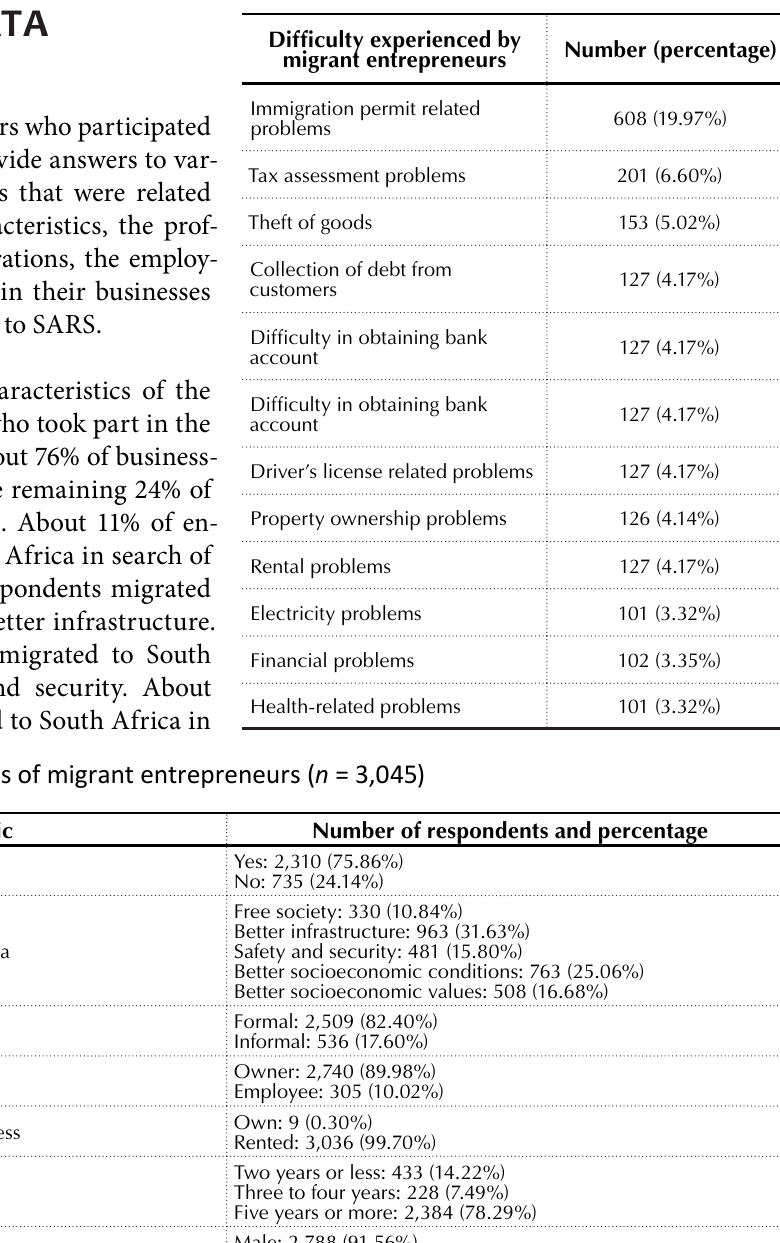
Table 2. Difficulties experienced by migrant